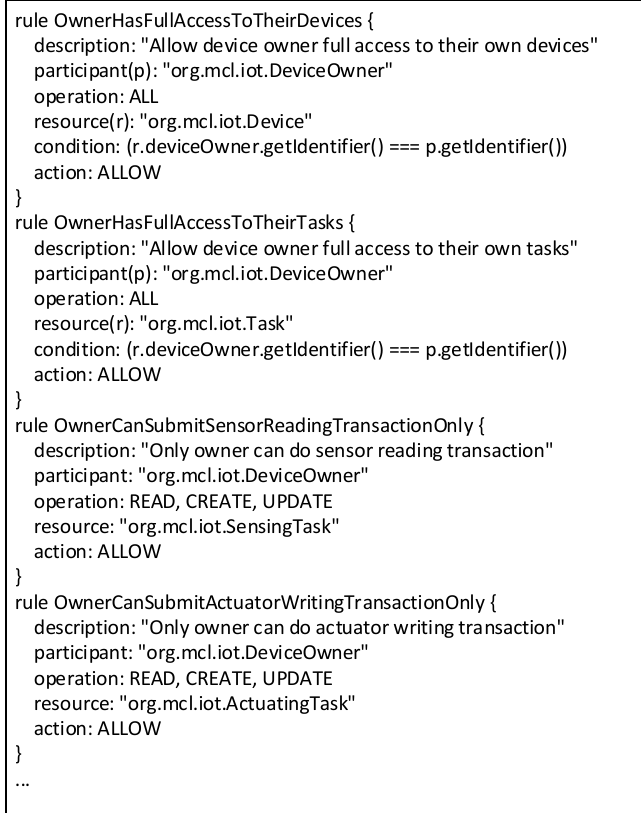
Figure 8. Access control rules in the smart contract.